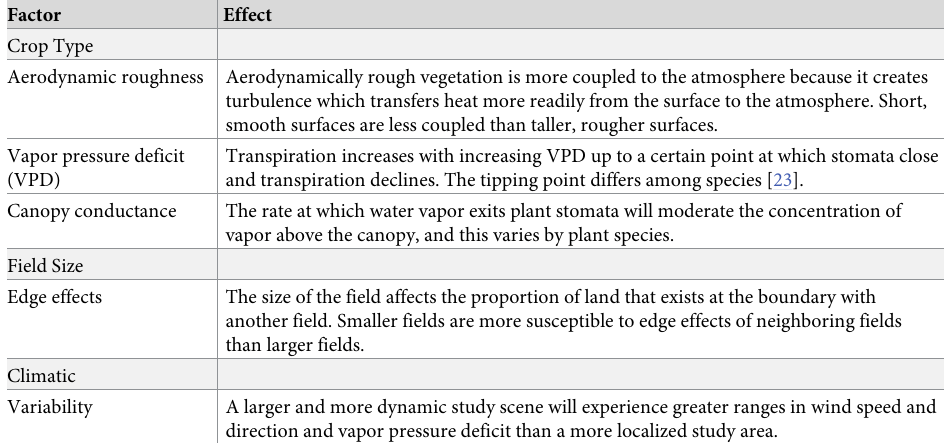
Table 2. Canopy-level and field level factors affecting plant/atmosphere interactions